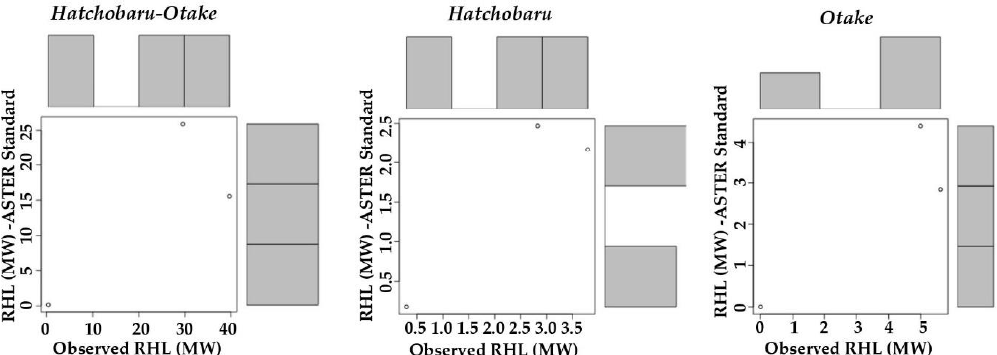
Figure 10 . Scatter plot and histogram between the observed and standard ASTER products base RHL from the study area.